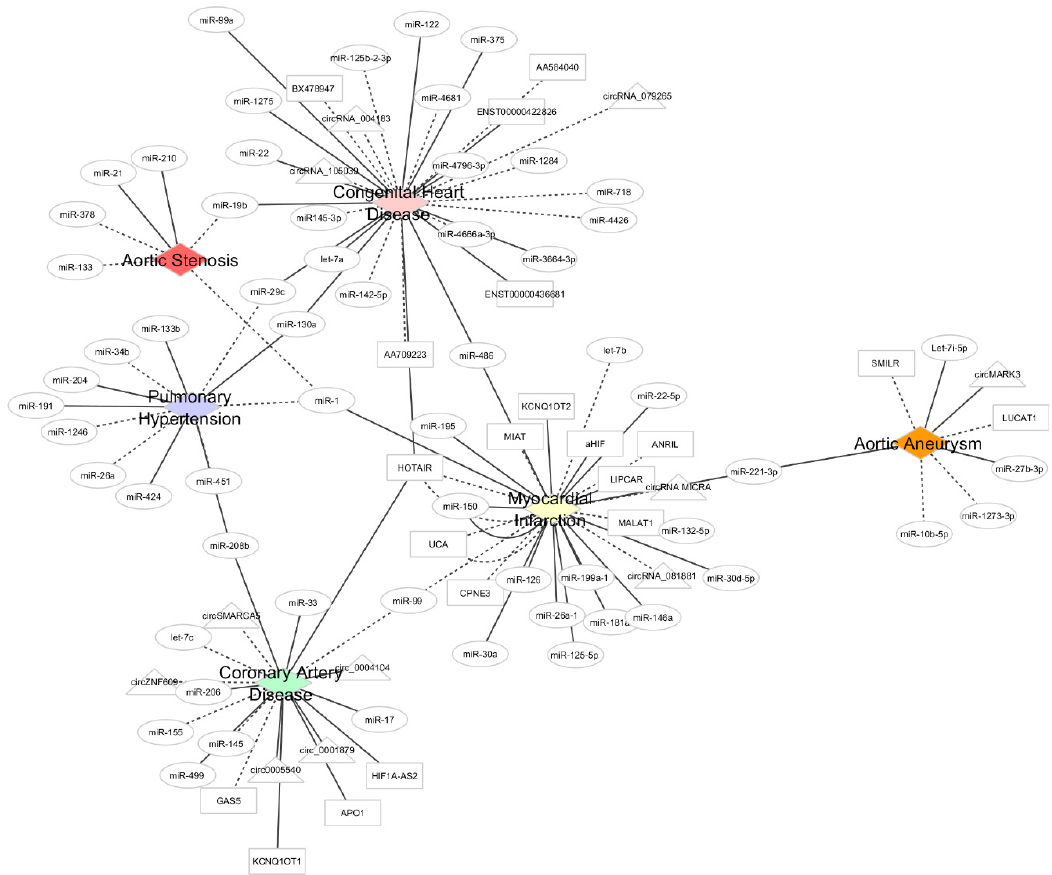
Figure 1. Illustrative cytoscape network combining the studies reported within this review. Aortic valve stenosis (red), congenital heart disease (pink), coronary artery disease (green), myocardial infarction (yellow), aortic aneurism (orange), and pulmonary hypertension (blue) are the five central nodes (diamond shape) and specific associations to ncRNAs are denoted by edges. The di ff erent ncRNAs are represented by di ff erent edges shapes: miRNAs are in circular shape, lncRNAs are in rectangular shape, and circRNAs are in triangular shape. Dashed lines represent upregulated plasma ncRNAs, while solid lines represent downregulated ncRNAs in plasma. Table 1. List of non-coding RNAs (miRNAs, lncRNAs, and circRNAs) involved in multiple cardiovascular diseases. AS, aortic valve stenosis; MI, myocardial infarction; PH, pulmonary hypertension; TOF, tetralogy of fallot; VSD, ventricular septal defect; ASD, atrial septal defect; PDA, patent ductus arteriosus; BAV, bicuspid aortic valve disease; CAD, coronary artery disease. Arrows indicate the direction of miRNA variation : ↓ and ↑ correspond to a under-expression and over-expression of the miR.